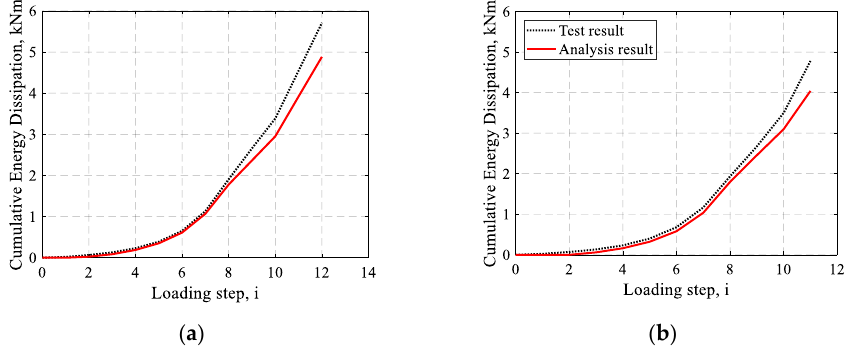
Figure 16. Comparison of analytical and experimental cumulative energy dissipation: ( a ) ST600; ( b ) ST450.